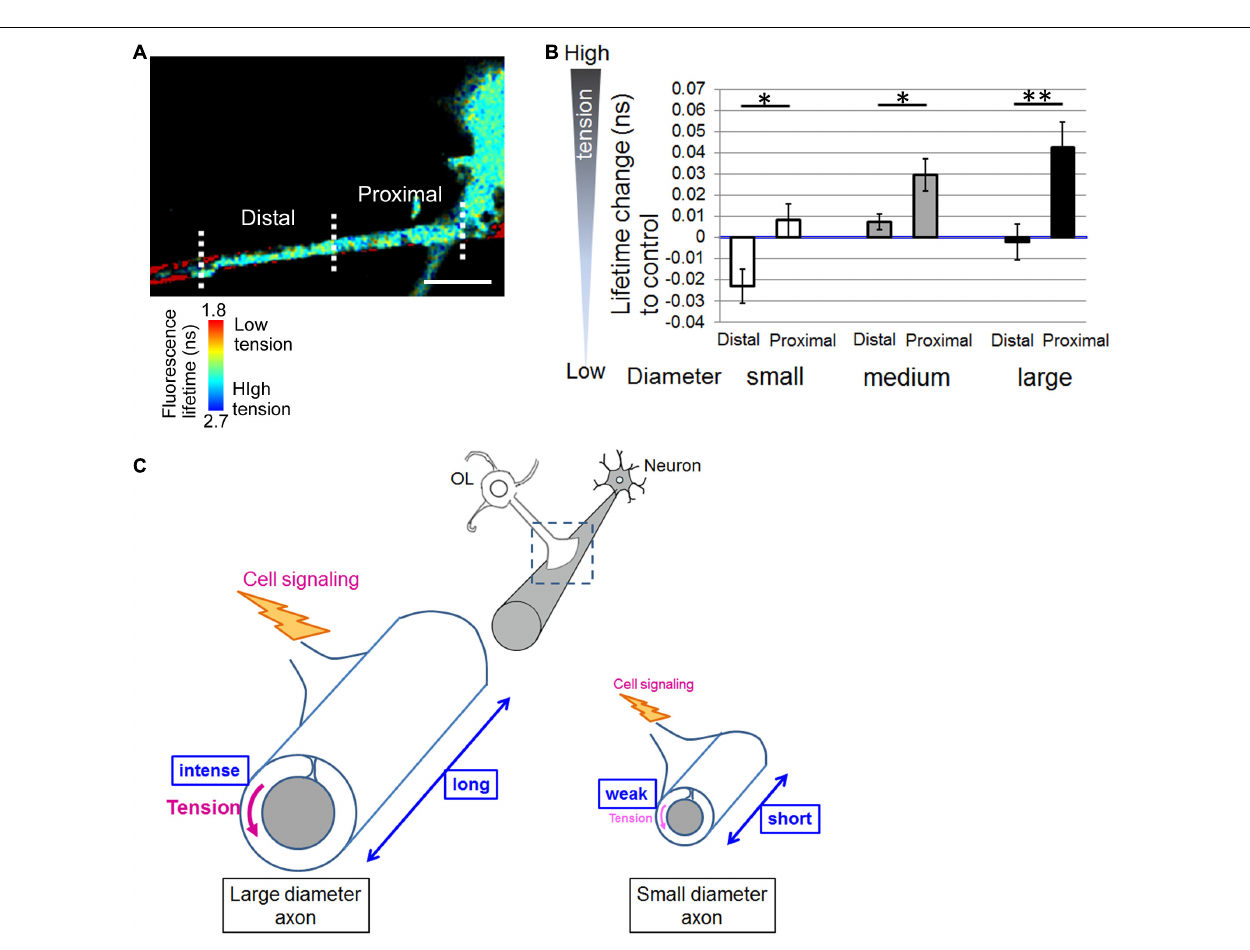
processes to ensheath axons, which is driven by actin